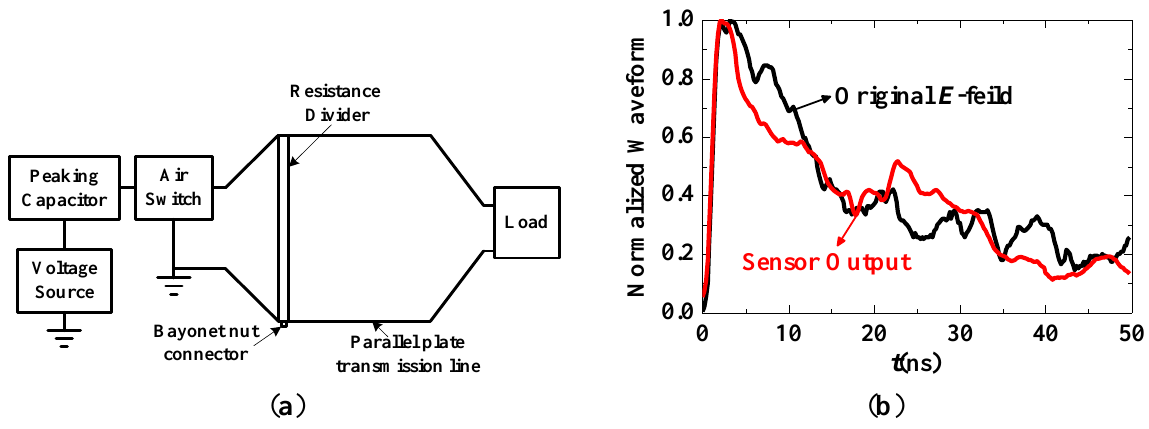
Figure 28. ( a ) NEMP simulator; ( b ) Normalized waveforms of the original E-field and the sensor